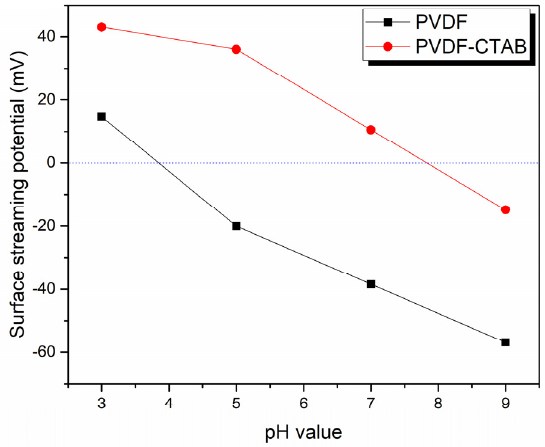
Figure 5. Surface streaming potential in different pH (3, 5, 7, 9) feed streams. PVDF represents the unmodified membrane and PVDF-CTAB indicates that blending CTAB in the PVDF doping solution leads to a more positive streaming.